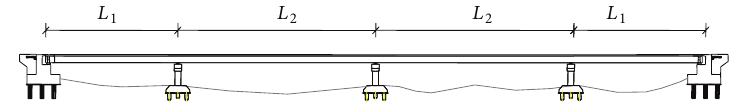
Figure 2: Bridge longitudinal